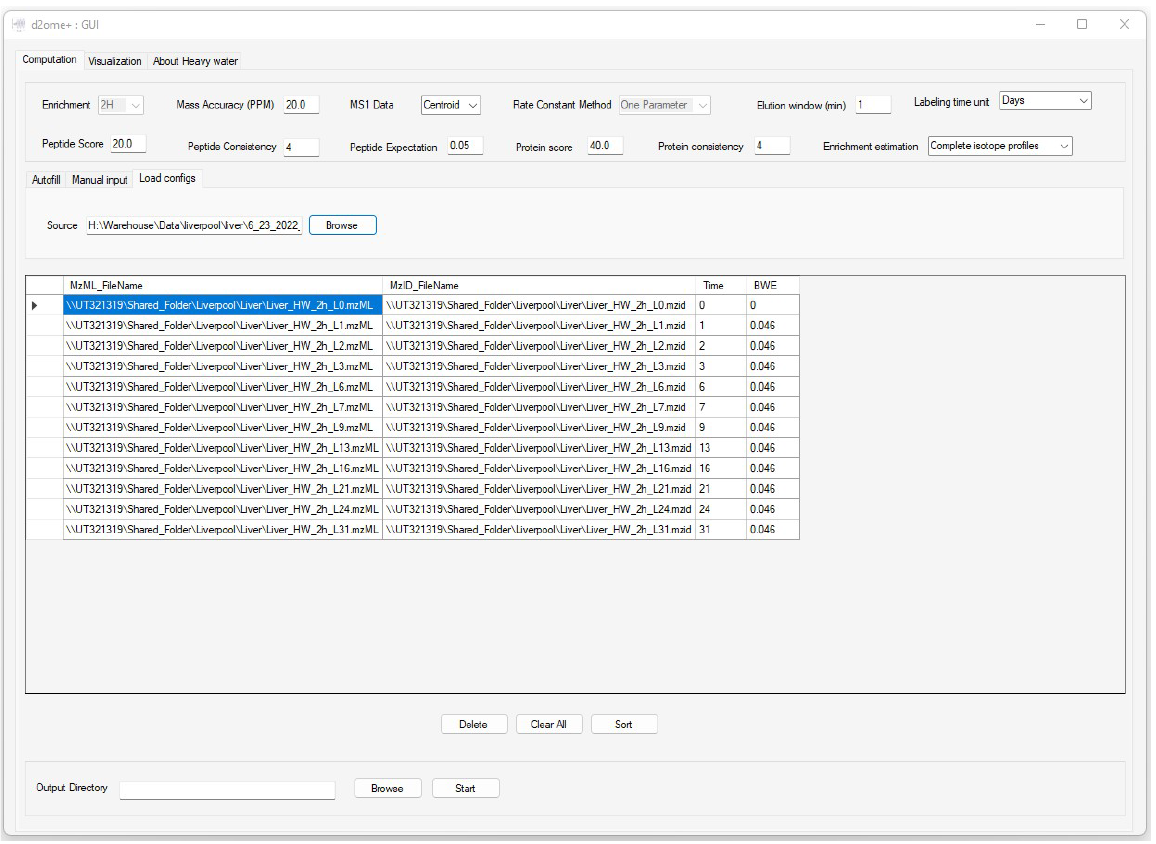
Figure 2. The graphical user interface (GUI) to input data and parameters for the protein turnover rate estimations. Time and BWE are the labeling duration and body water enrichment in deuterium for the corresponding mzML and mzid files (experiments).